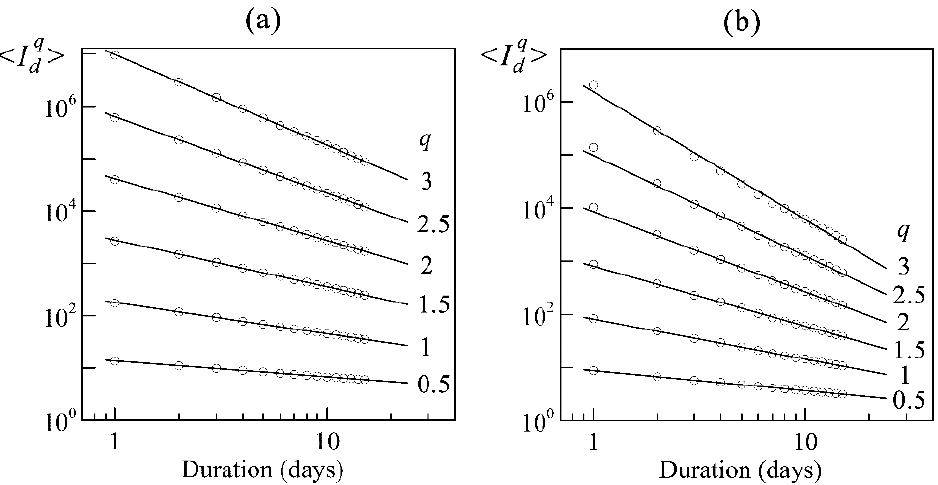
Figure 2. Statistical moments of the rainfall intensity at Grazalema ( a ) and the airport of Málaga ( b ). Straight lines indicate scale invariance.